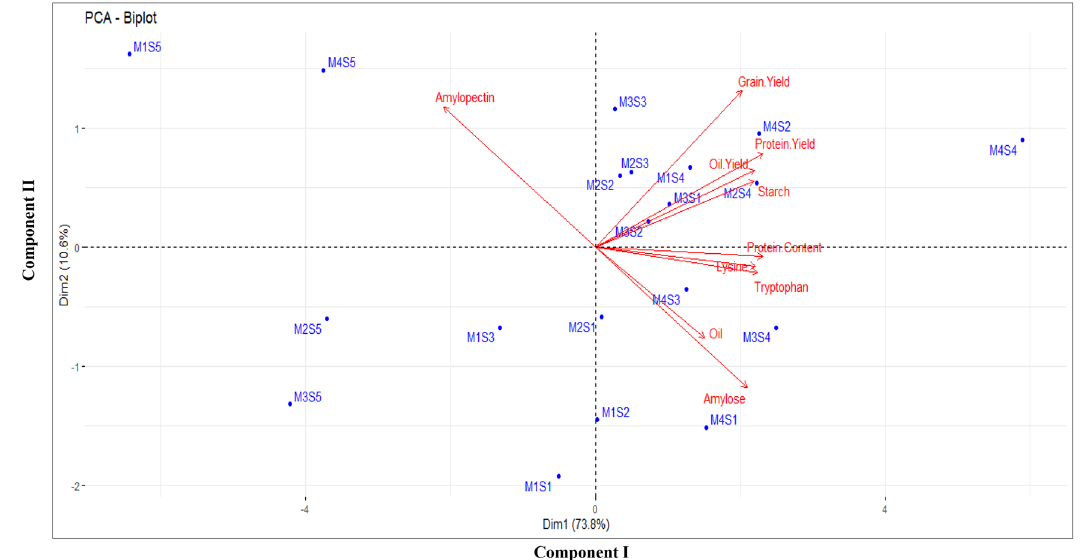
Figure 8. PCA biplots showing the effect of different treatment combinations of CETMs and PFPs on productivity and quality parameters of maize (pooled data).